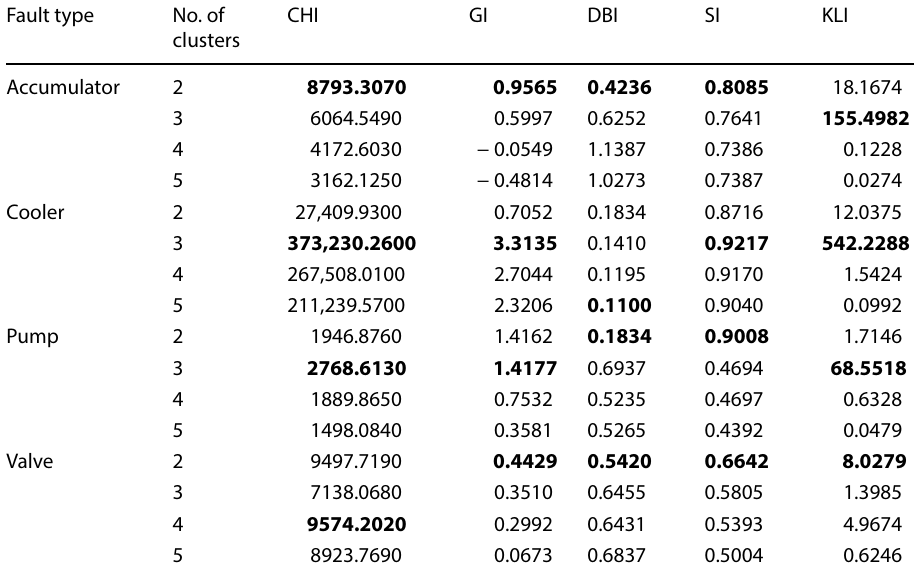
Table 4 Optimal number of